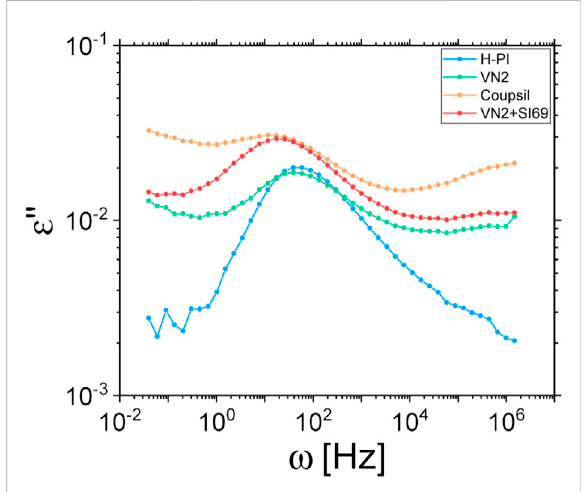
FIGURE 8 Alpha relaxation of theneat polyisoprene matrix anddifferent fi ller types, with or without silane coupling agent, measured by dielectric spectroscopy at 223